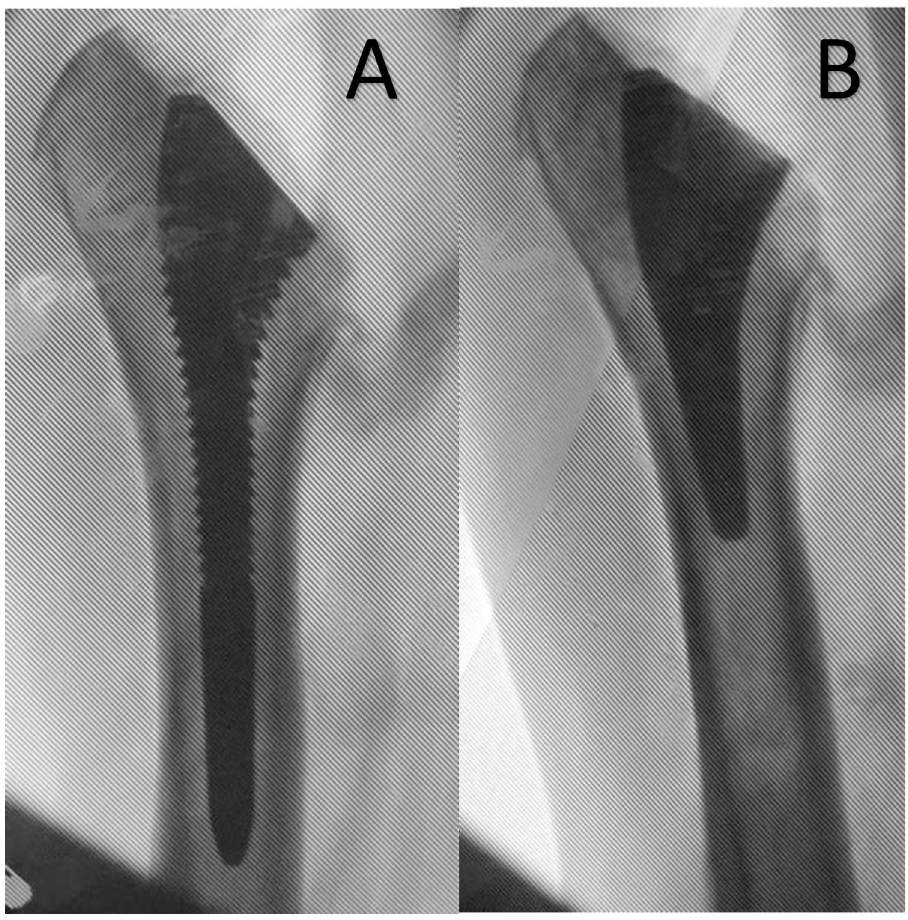
Fig 4. True anteroposterior humeral radiographs showing well aligned implants (size 7), without cortical contact ( A ) trial (alpha angle 0,5˚), ( B ) short-stem (alpha angle 0,1˚), in the same